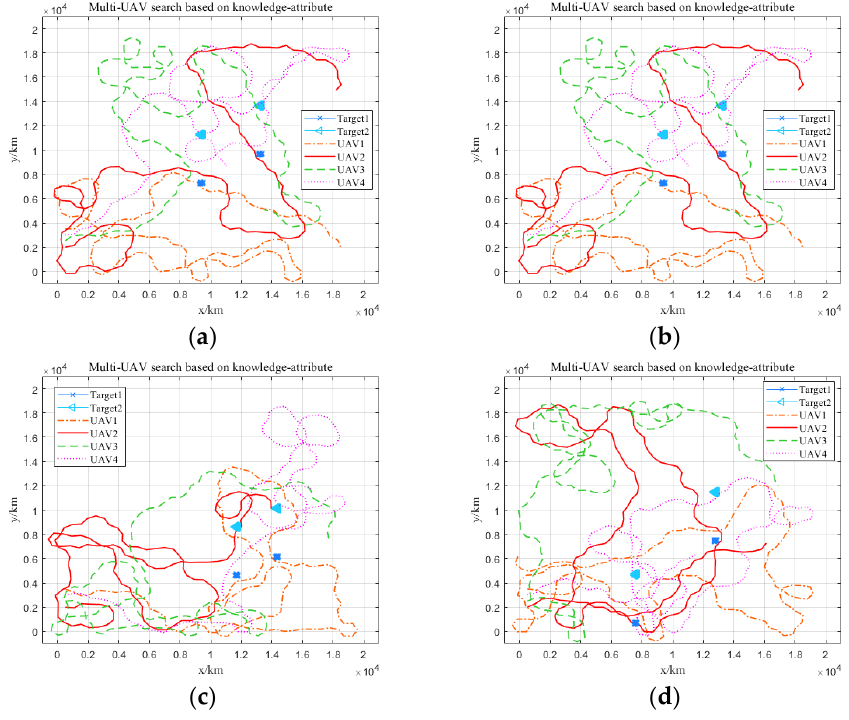
Figure 5. Search track of UAVs in Scenario 1: ( a ) RI-MAC, ( b ) MAC, ( c ) ABC, ( d ) PSO.